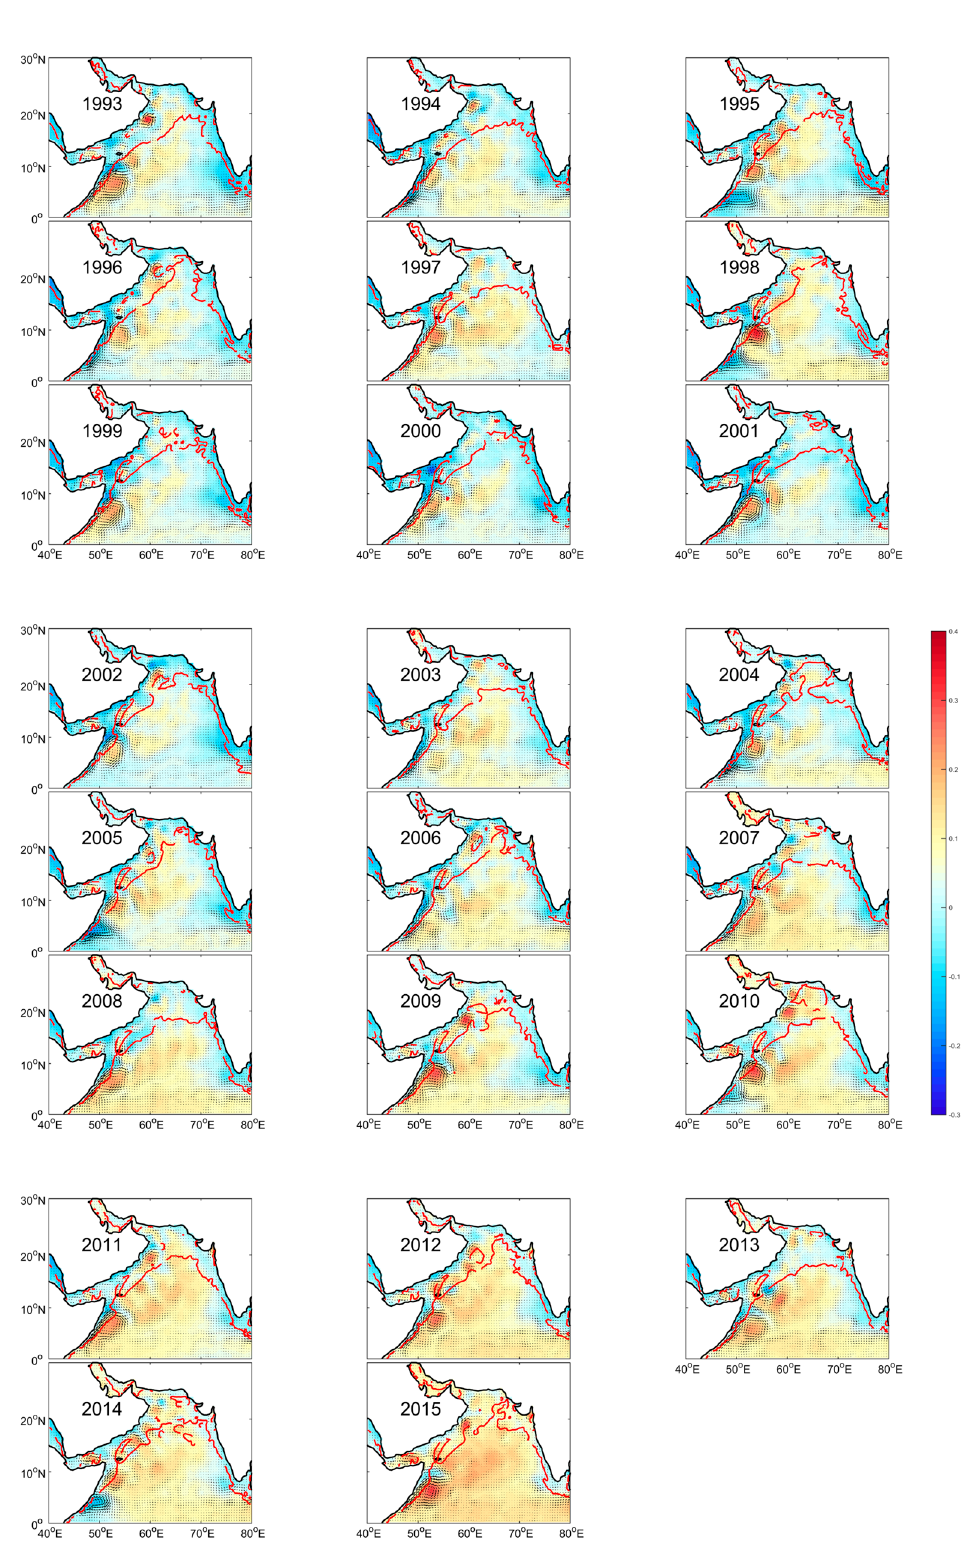
Figure 7. Mean state of the GW during the southwest monsoon from 1993 to 2015 (background color is SLA, unit: m; the vectors is sea surface flow, unit: m · s − 1 ). The red line represents the contour of the zero sea surface wind stress curl.